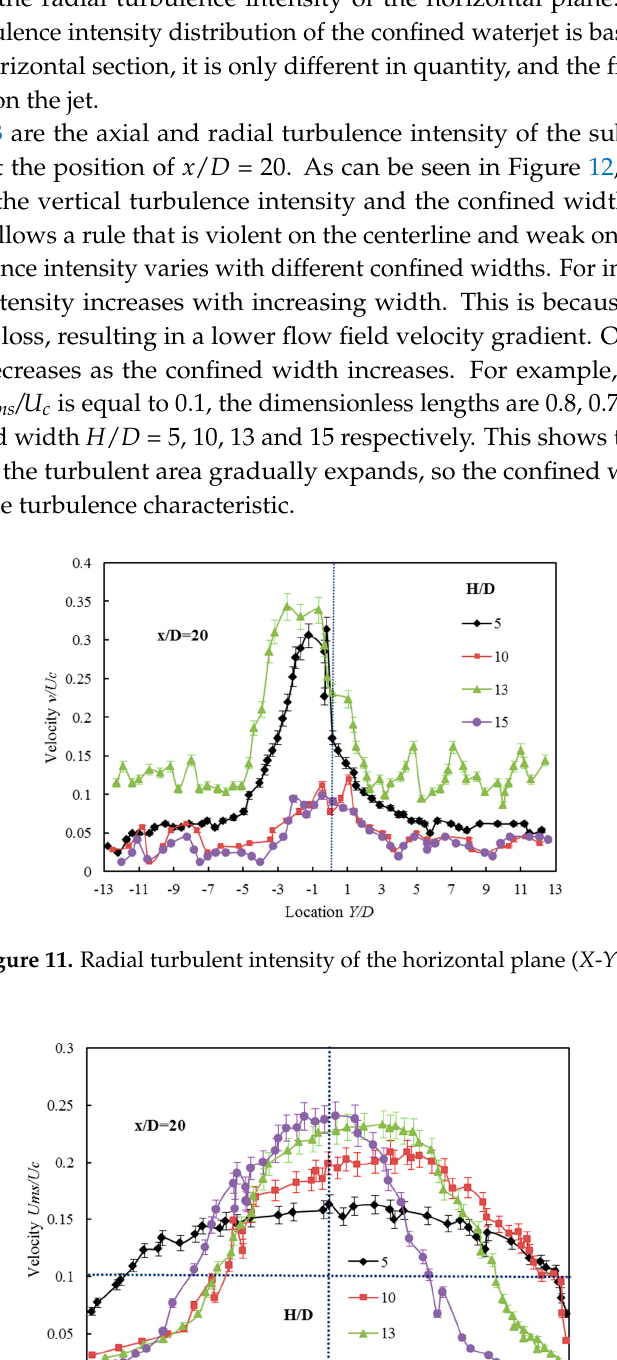
Figure 12. Axial turbulent intensity of the vertical plane ( X - Z ).